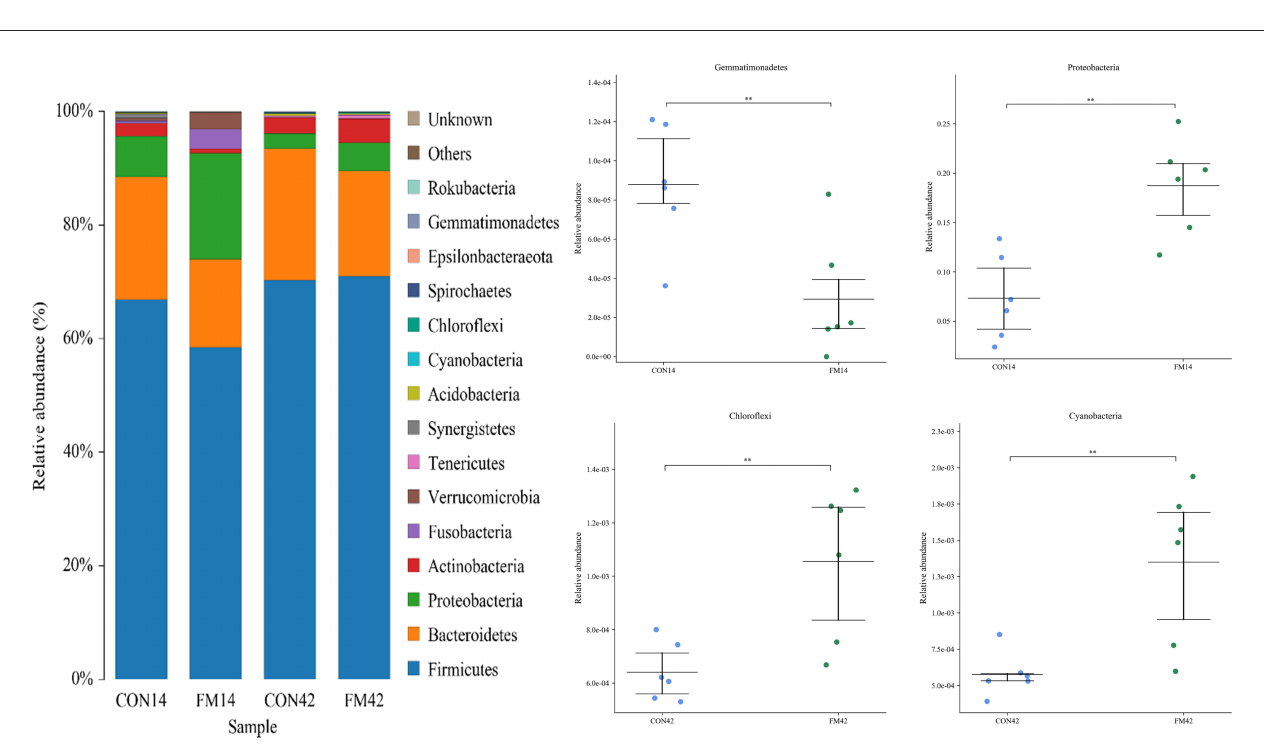
( p < 0.01), Megasphaera ( p < 0.01) decreased at day 42 in the FF